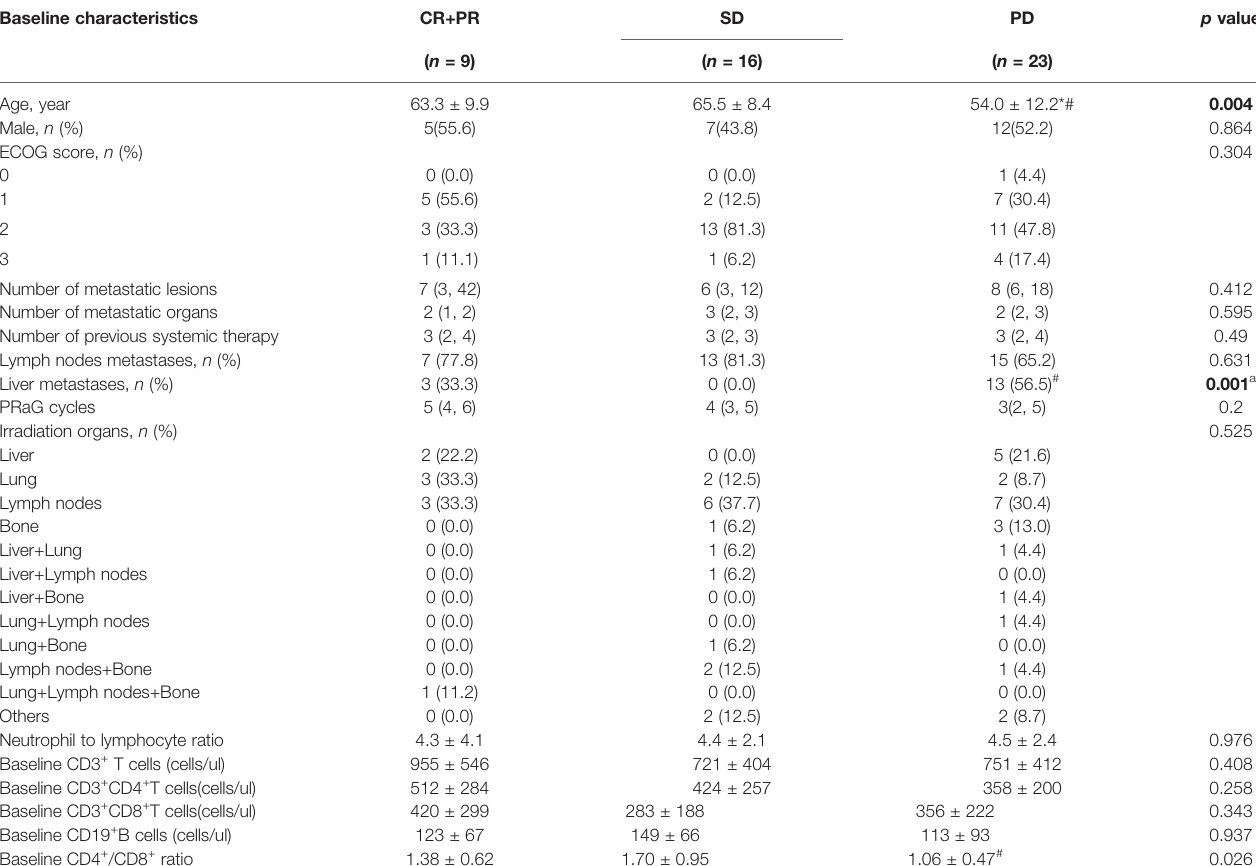
TABLE 3 | Comparison of characteristics between complete response (CR)+partial response (PR), stable disease (SD), and progressive disease (PD) groups after treatment. Baseline